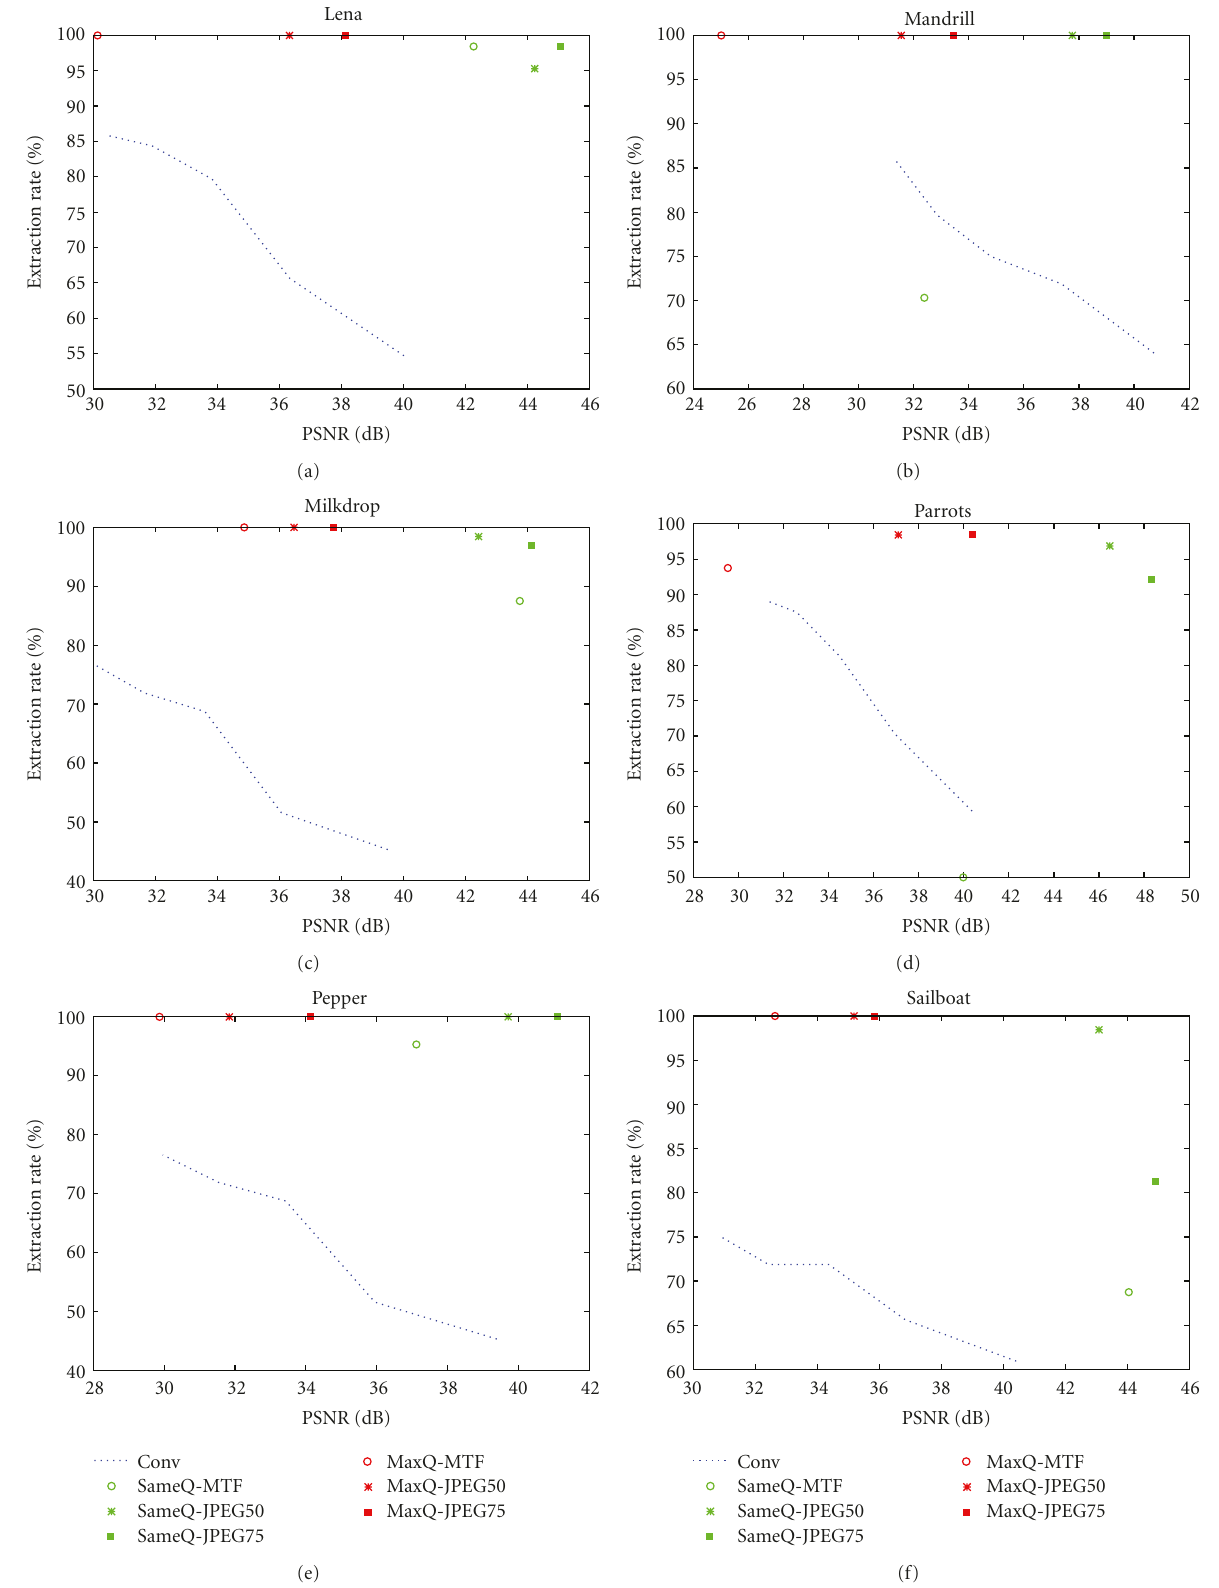
Figure 19: Comparison in the robustness against JPEG compression of quality 90%